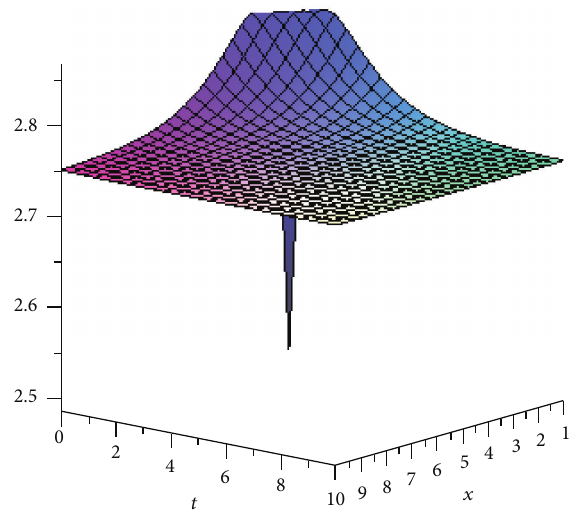
Figure 2: The solution 𝑉 3 in (33) with 𝛾 = 4/5 , 𝑘 = 𝑐 = 𝜎 = 𝑏 2 = = 1 , 𝜇 = −1 , 𝜉 = 0 , 𝑒 = 1 . 𝑓 2 0 0